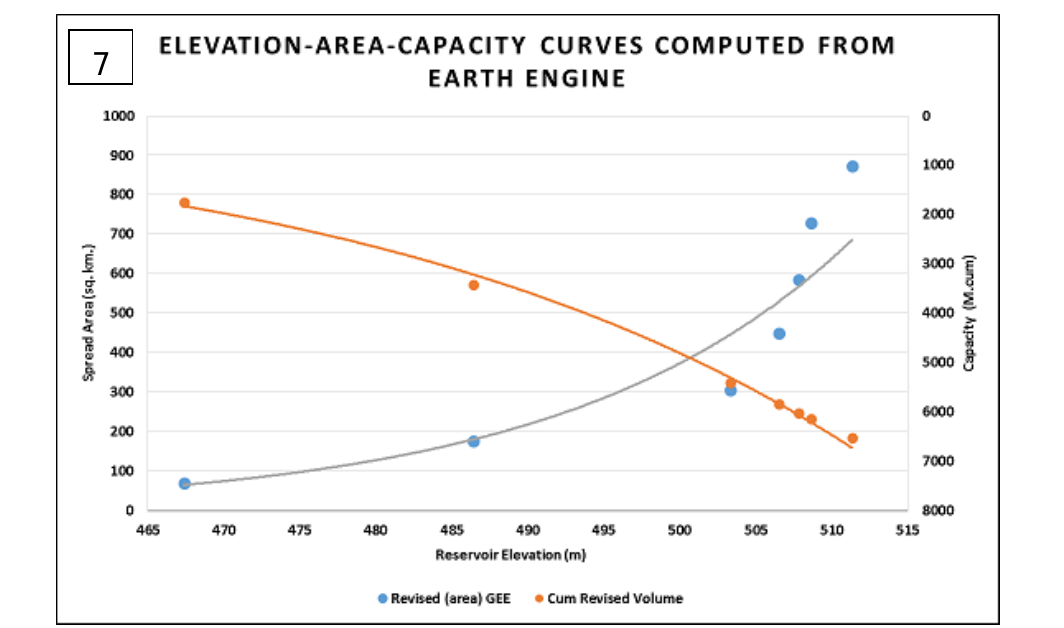
Fig. 5 Elevation-Area curves for Gobind Sagar Reservoir, India (2017-2018) Fig 6 Elevation-Capacity curves for Gobind Sagar Reservoir, India (2017-2018)